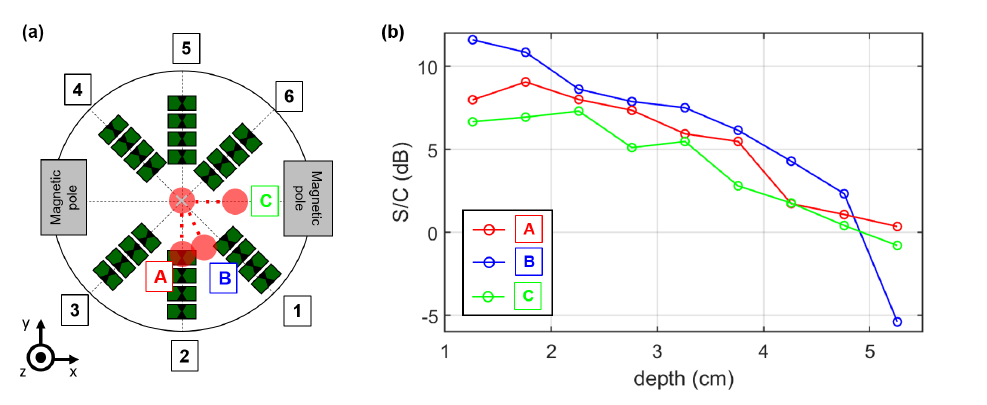
Figure 10. ( a ) Schematic of the antenna array and the target positions. ( b ) Corresponding signal-to- clutter ratio ( S / C ) depending on the target depth for the three different axes A, B, and